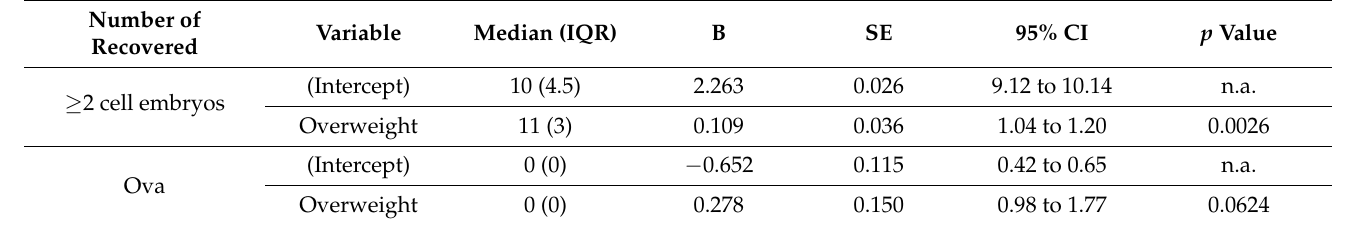
Table 3. Univariate Poisson regression for the number of recovered ≥ 2 cell embryos and for the number of recovered ova (oocytes & degenerates) on embryonic day 2 in fertilized female mice (i.e., mated and ovulating females with at least one embryo in the reproductive tract).